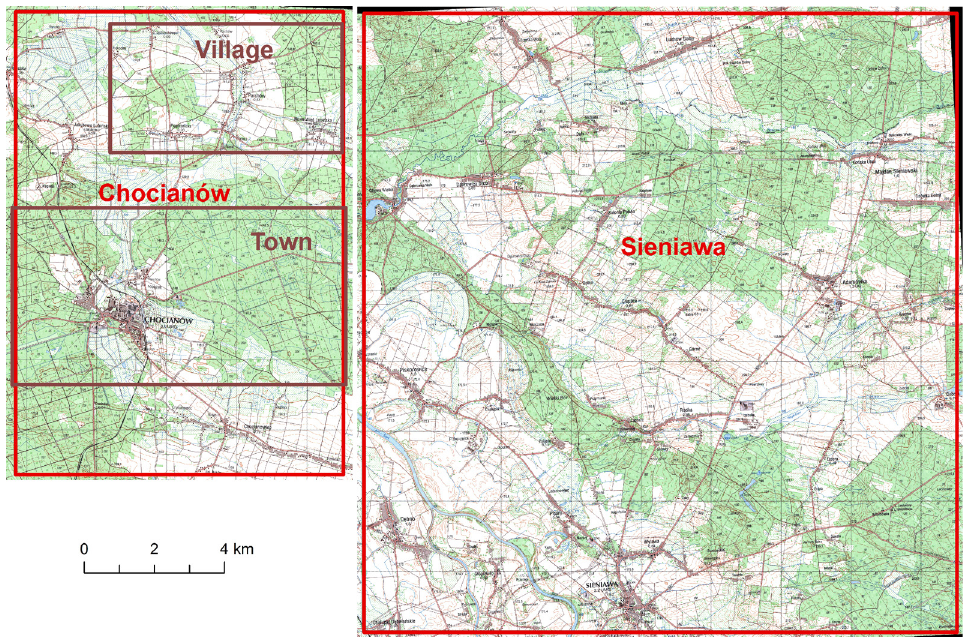
Fig. 2. 1:50,000 analog maps − the reference material with marked research